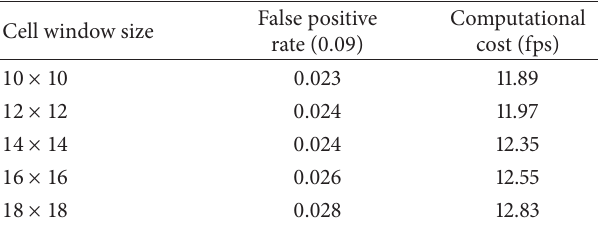
Table 2: The miss rates of various cell windows